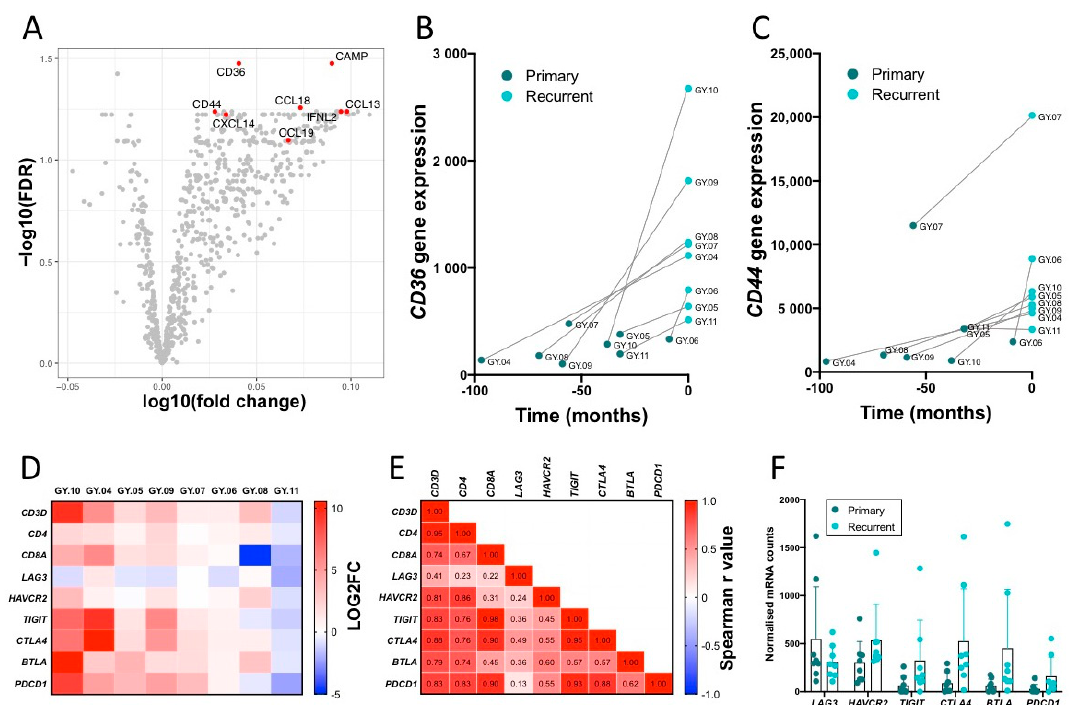
Figure 5. NanoString analysis of top upregulated genes in recurrent tumor compared to primary tumor samples. ( A ) Volcano plot showing Log2 fold change and the false discovery rate (FDR) using the primary tumor samples as the baseline. Illustration of expression of CD36 ( B ) and CD44 ( C ) over time (months from primary to recurrence). Statistical analysis was performed with a Wilcoxon test. ( D – F ) shows the expression of T cell marker genes and immune checkpoint genes. ( D ) Heatmap showing the log2 fold change values of the expression of selected genes from the primary and recurrent tumor samples. Red indicates high expression and blue indicates low expression. ( E ) Spearman correlation matrix with r values. Red indicates a strong positive correlation, blue indicates a strong negative correlation and white indicates no correlation. ( F ) Gene expression levels of immune checkpoints in primary and recurrent tumors. Statistical significance between expression levels in primary and recurrent samples was tested using multiple Wilcoxon tests. No significant changes were found with adjusted p values, false discovery rate (FDR), LAG3 : p = 0.252, HAVCR2 : p = 0.252, TIGIT : p = 0.224, CTLA4 : p = 0.118, BTLA : p = 0.118, PDCD1 : p = 0.224.